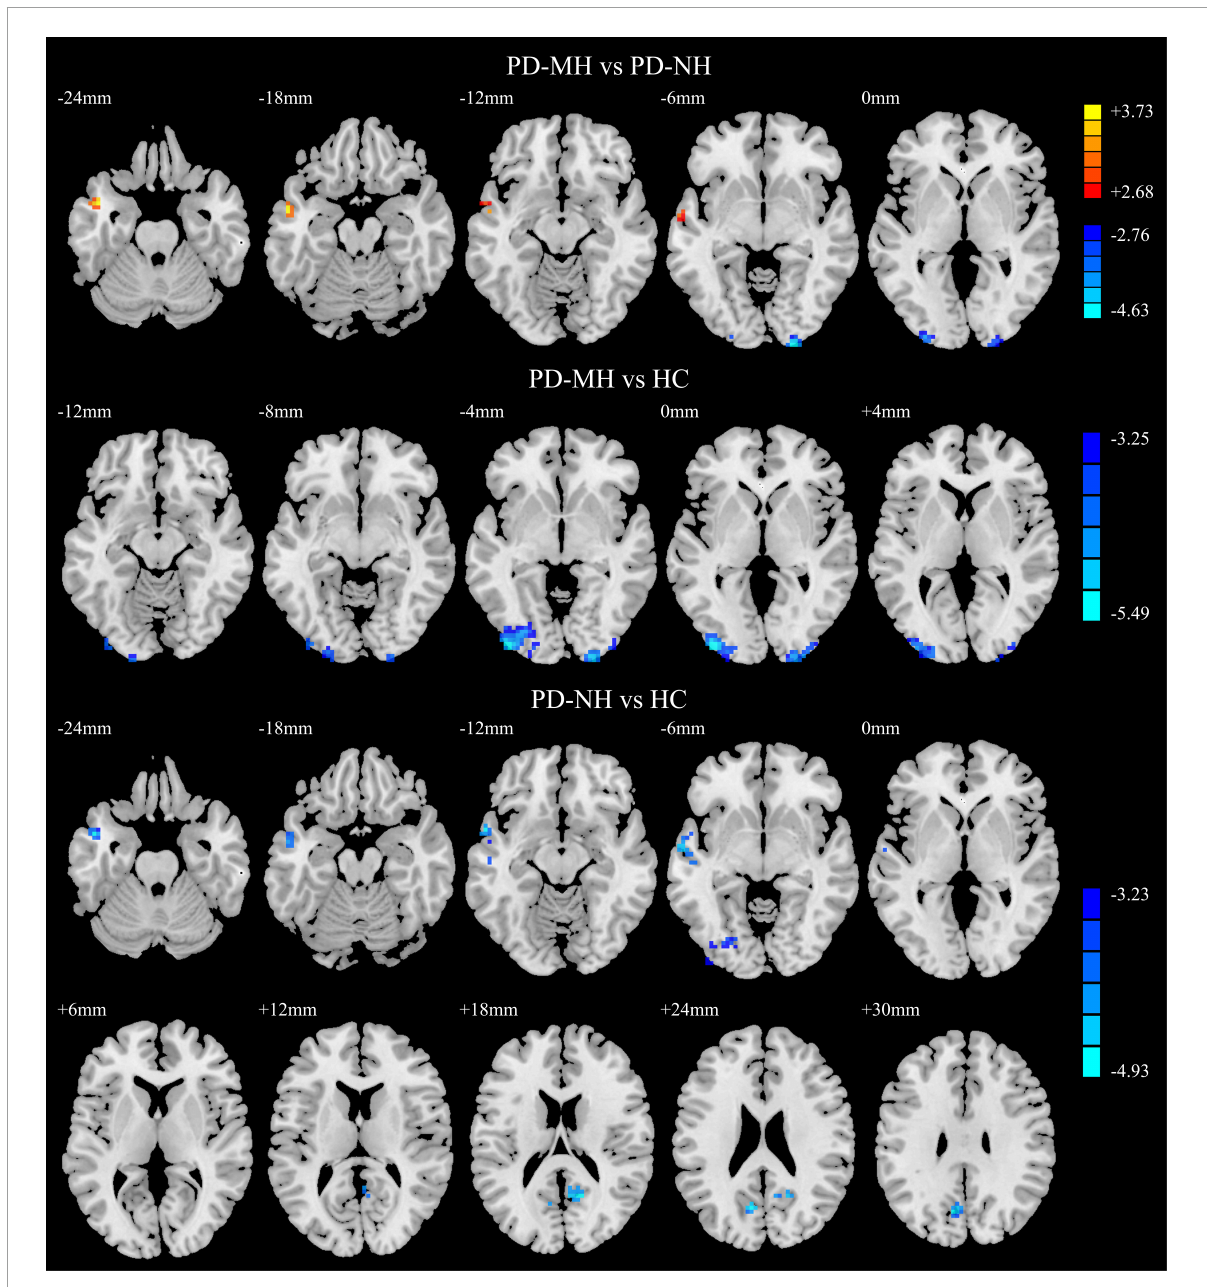
FIGURE4 Significant differences of functional connectivity between the groups. Red and yellow indicated increased functional connectivity. Blue and green indicated reduced functional connectivity. Using GRF correction, voxel level P < 0.001 and cluster level P < 0.05 were considered statistically significant difference. PD, Parkinson’s disease; MH, minor hallucination; NH, no hallucinations (and delusions); HC, healthy control; GRF, Gaussian random